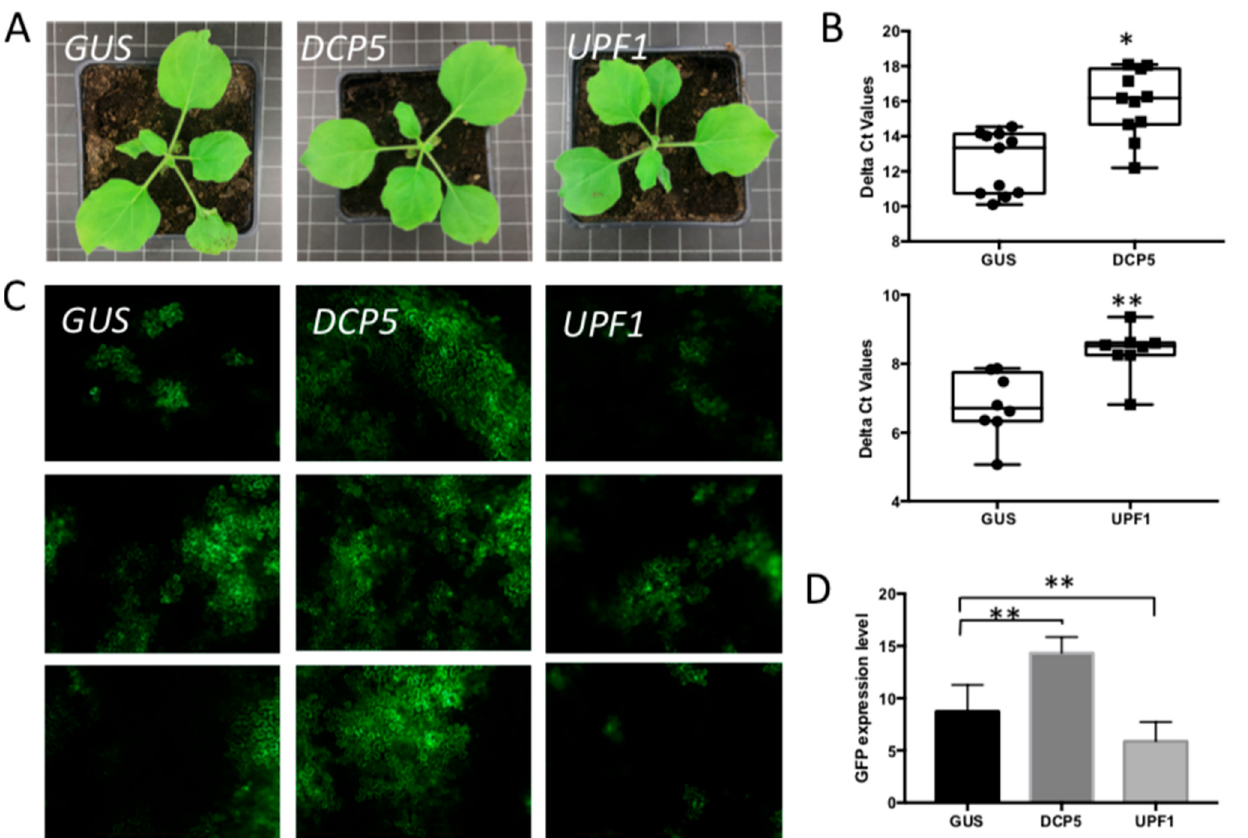
Figure 4. The effect of silencing P body elements on TSWV replication. ( A ) Plant phenotype after VIGS-silencing DCP5 and UPF1 , compared with GUS -silenced control plant. ( B ) qRT-PCR assay to quantify the silencing efficiency. Non-parametric t test was performed. * p -value < 0.05, ** p -value < 0.01. ( C ) Green fluorescence resulting from eGFP expression from a TSWV replicon in plants silenced on P body elements, and control plants. Plants were infiltrated TSWV-eGFP replicon constructs 2.5-week post silencing and harvested at around 60 hpi. ( D ) Statistical analysis of GFP intensity in the silenced plants and control plants. A non-parametric t test was performed. * p -value < 0.05, ** p -value < 0.01.